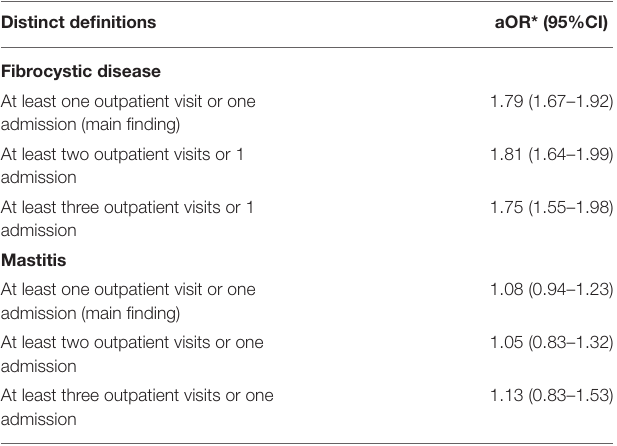
TABLE 3 | Sensitivity analysis in the estimation of the SS risk for exposure in the age-matched